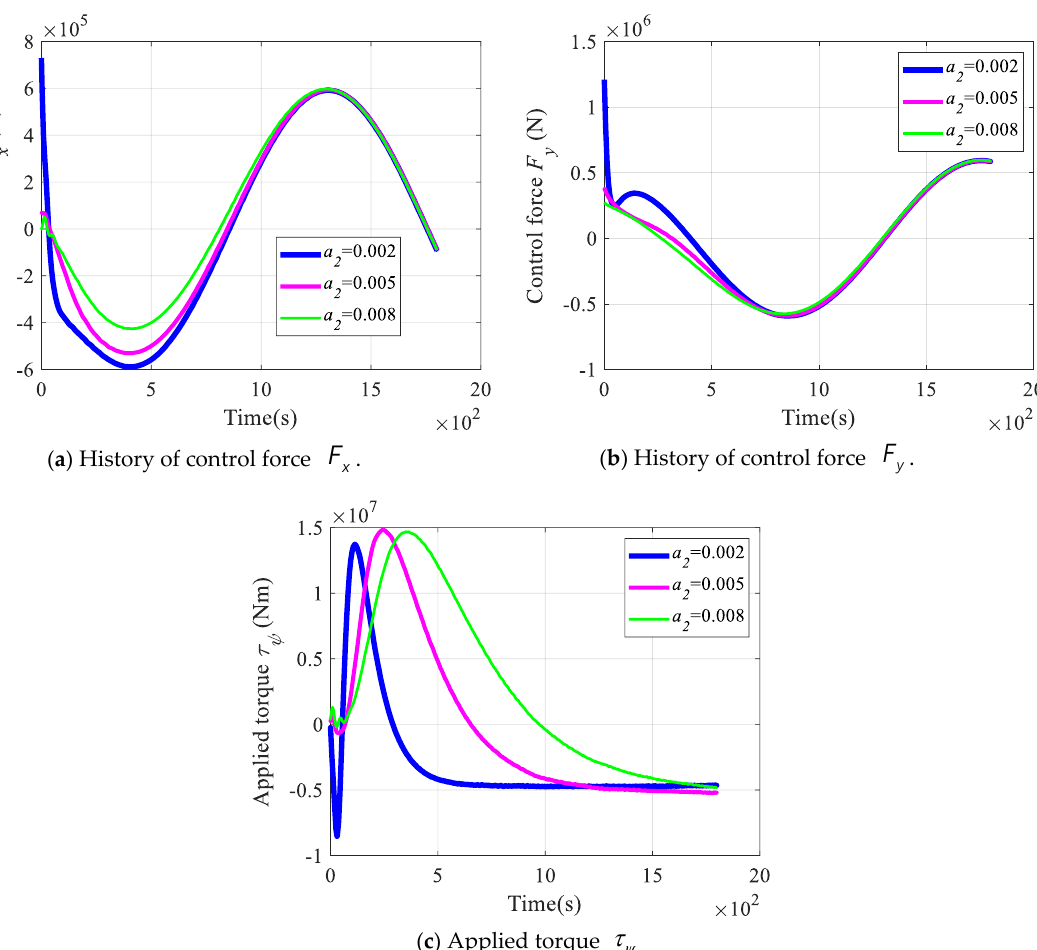
Figure 12. Tracking errors of controlled AUSV with respect to different control gains